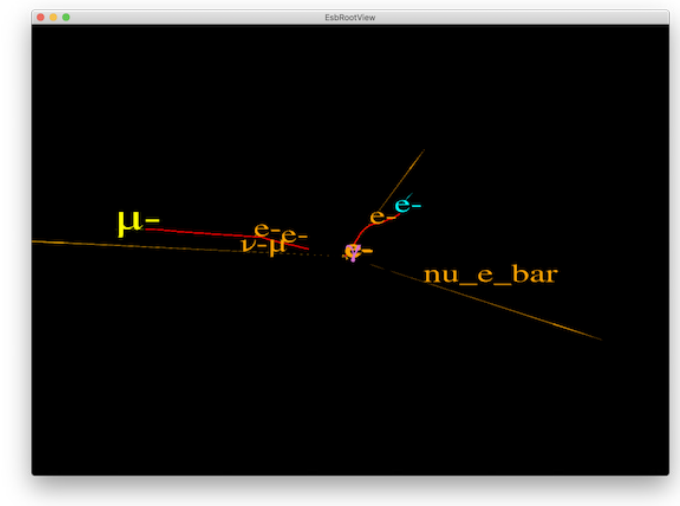
Figure 1. A muon decay topology.